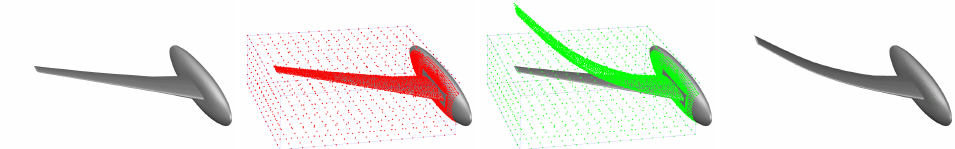
Figure 1. Example of RBF setup. The first mode of vibration is imported from FEM. Resulting deformation is amplified by